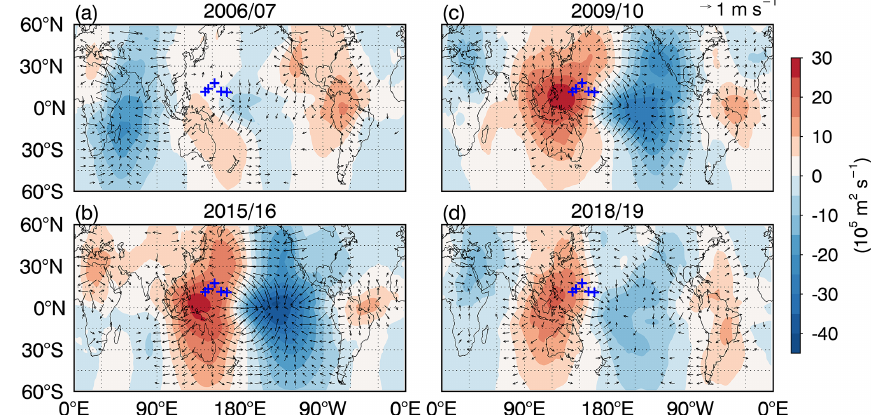
Figure 5. Anomalies of velocity potential (shading) and divergent wind (arrows) at 850hPa in the winters of (a) 2006/07, (b) 2015/16, (c) 2009/10, and (d) 2018/19. The blue pluses denote the five radiosonde